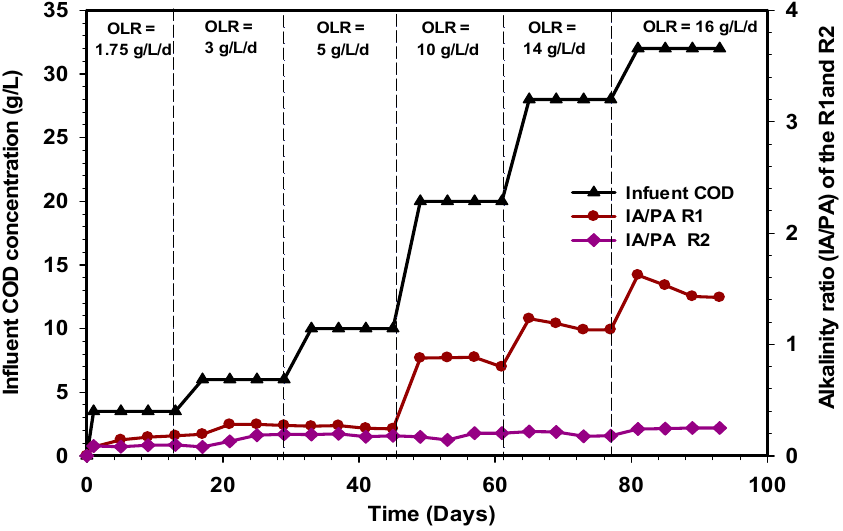
Figure 7. Variation of alkalinity ratio in the R1 and R2 reactors .